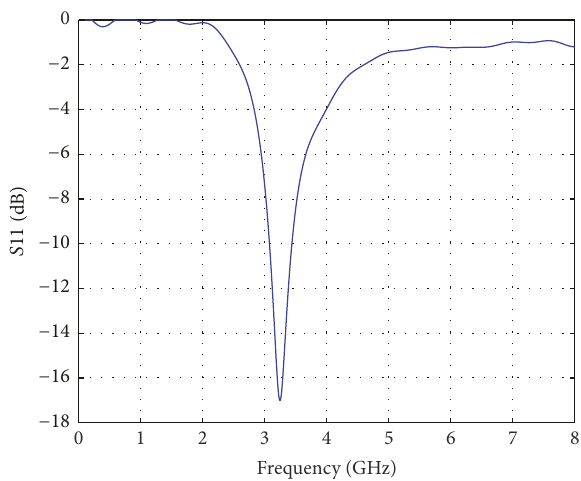
Figure 2: Impulse response of monopole antenna with the delayed time parameter 𝑇 indicated.